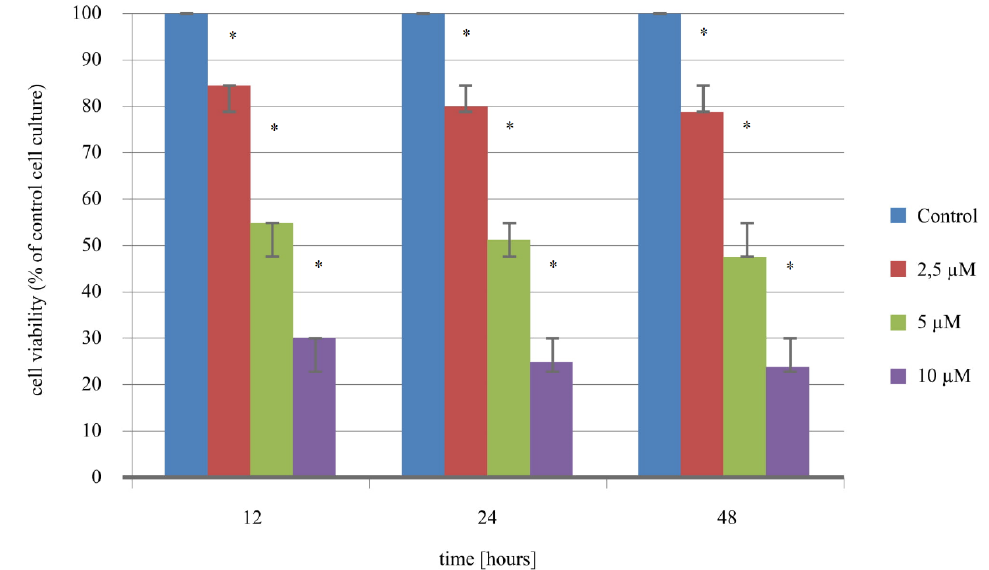
Figure 1. Outcomes of the Sulforhodamine B cytotoxicity assay (*—statistically significant differences in comparison to the control cell culture; p < 0.05).